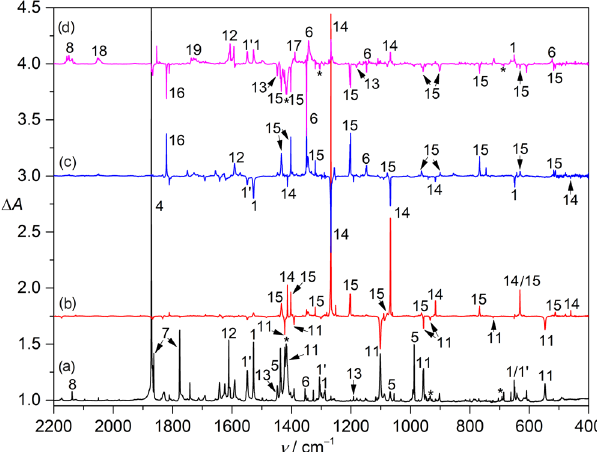
Fig. 3 IR spectra showing the formation and photochemistry of CH 3 SOO (cid:129) (11) and CH 3 S(O) 2 OO (cid:129) (15). a IR spectrum of the HVFP products of CH 3 SNO/O 2 /Ar (1:50:1000) at 10 K. b IR difference spectrum re fl ecting the change of the HVFP products upon red-light irradiation (830 nm, 20 min). c IR difference spectrum re fl ecting the change of the HVFP CH 3 S (cid:129) ··· (cid:129) ON ( 16 ), SO 3 ( 17 ), OCS ( 18 ), CH 2 O ( 19 ), and CH 3 SSCH 3 (*) are